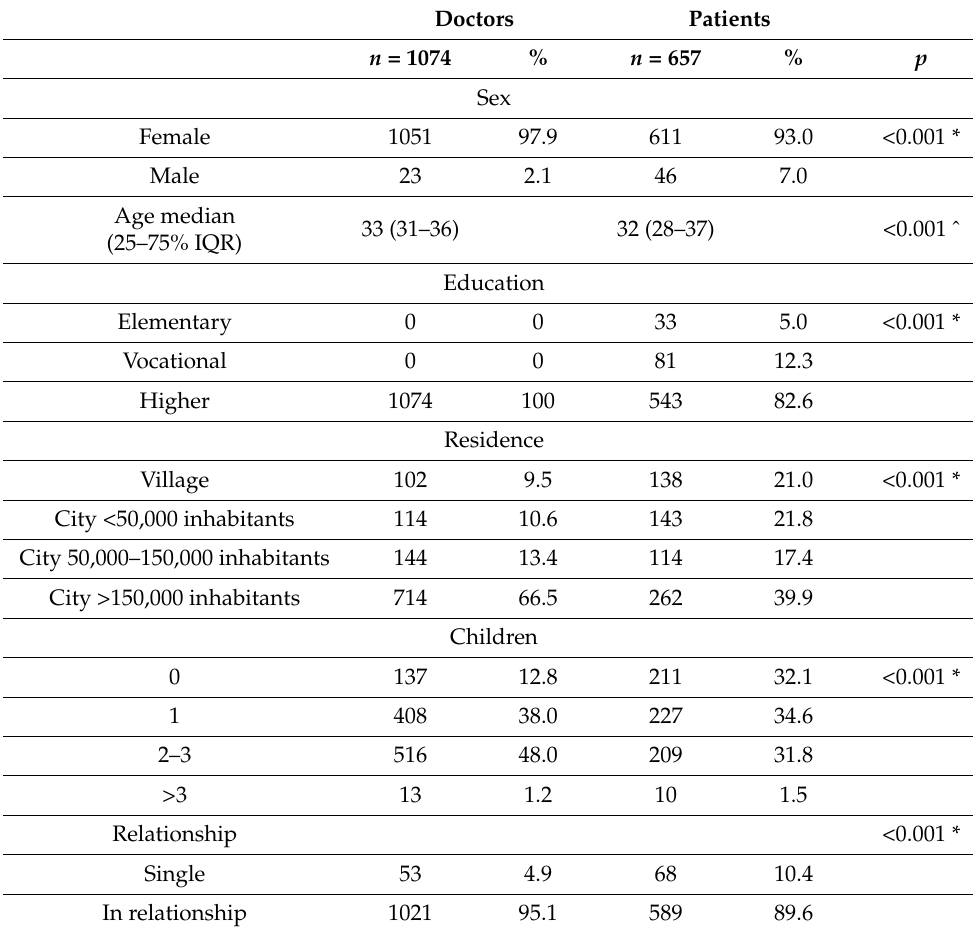
Table 1. Characteristics of respondents. (IQR—interquartile